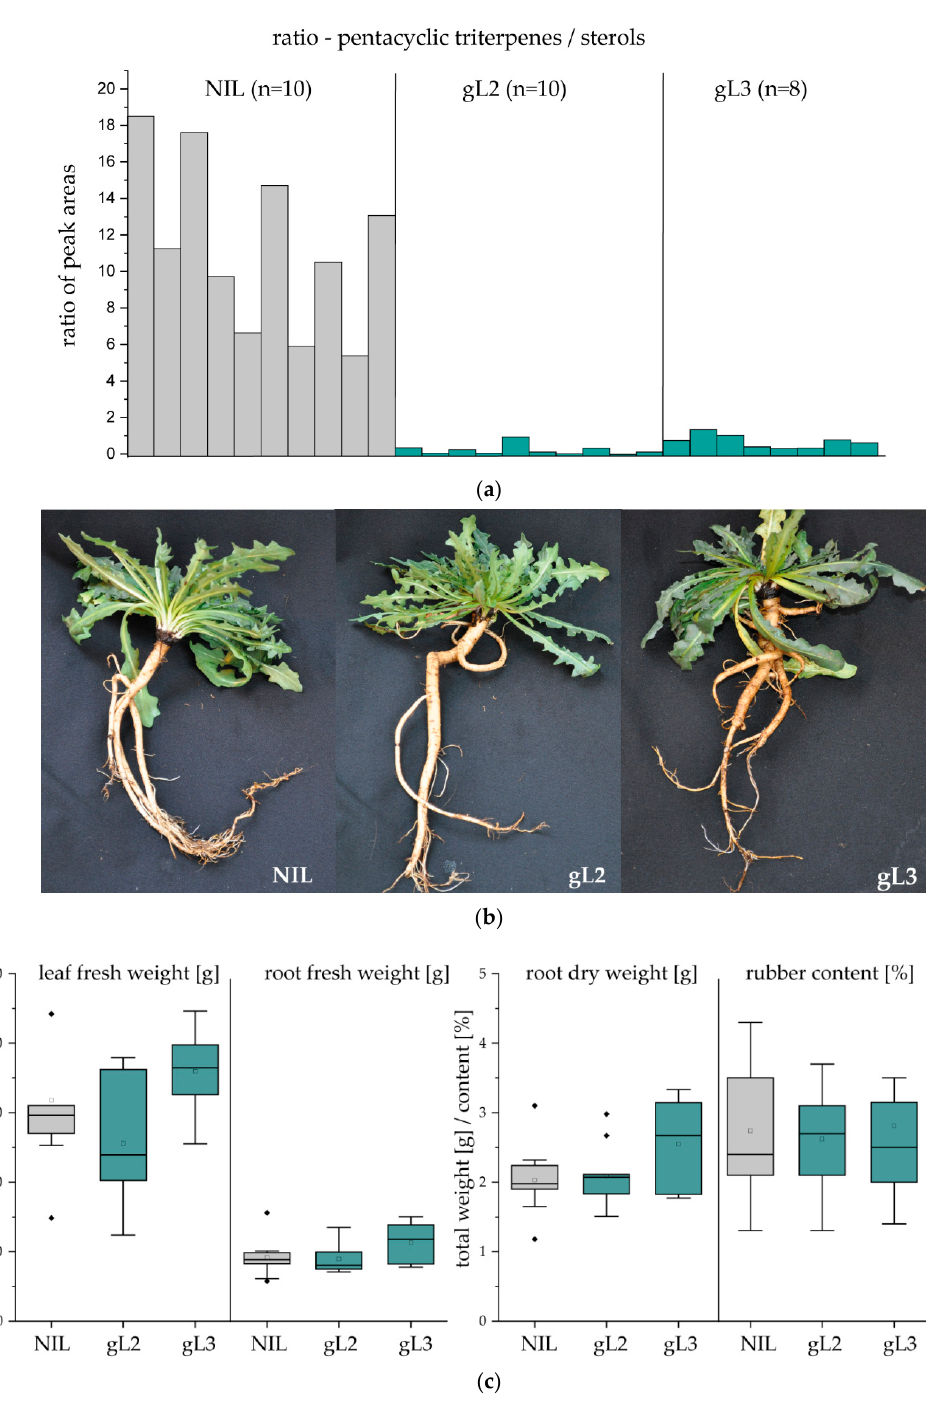
Figure 4. Analysis of TkOSC -RNAi plant lines gL2 and gL3 from the T1-generation in comparison to near isogenic lines (NIL). ( a ) Screening of T1 plants by fast triterpene extraction from root material; the ratio of the dominant triterpene end-products ( α -, β -amyrin and taraxasterol) and sterols (campesterol, stigmasterol and sitosterol) was calculated in acetone extracts analysed by GC–MS; ( b ) representative pictures of 12-week-old plants after harvesting; ( c ) quantification of leaf and root fresh weight, root dry weight and rubber content (determined by 1 H-NMR analysis) of 12-week-old plants (NIL and L2, n = 10; L3, n = 8); no statistical significant di ff erences could be